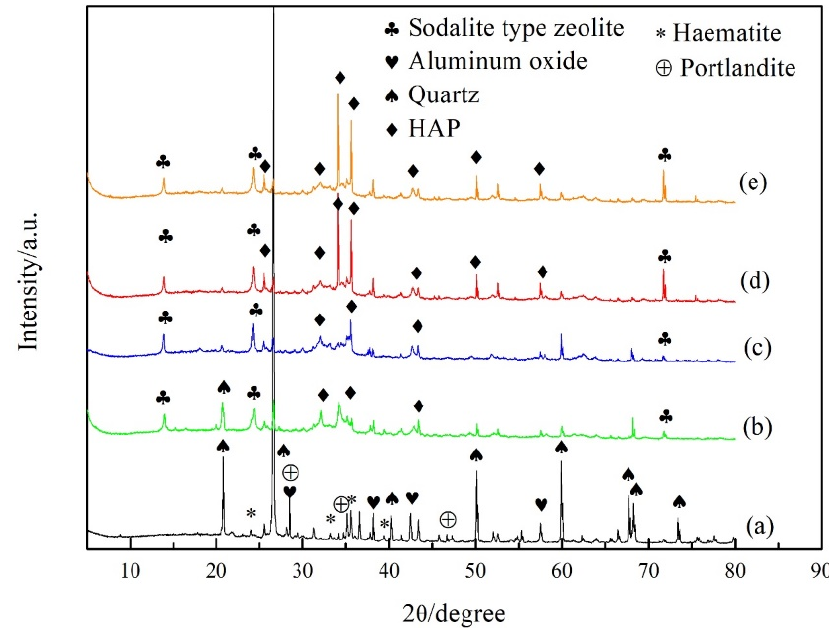
Figure 1. XRD patterns of ( a ) BFS; the HAP-ZE samples obtained at reaction temperature of ( b ) 80 °C; ( c ) 90 °C; ( d ) 100 °C and ( e ) 120 °C. Table 2. The crystallinity, phase contents and indicator parameters of HAP-ZE synthesized at the various reaction temperatures. Reaction Crystallinity a Temperature/ ◦ C